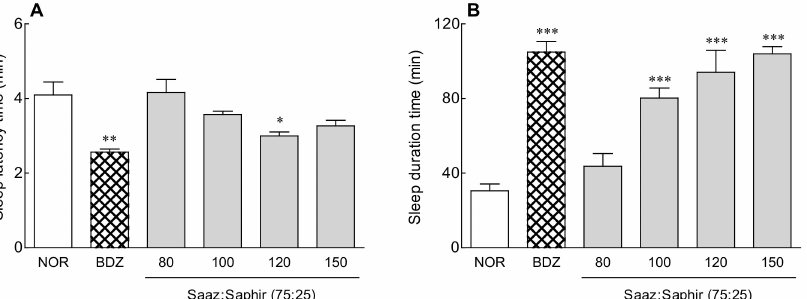
Figure 1. Effects of hops on the sleep latency time ( A ) and total sleep time ( B ) in mice that received a hypnotic dose of pentobarbital (42 mg/kg, i.p.). NOR: the 0.9% NaCl (physiological saline) group (normal control); BDZ: benzodiazepine treatment (positive control, 200 µ g/kg); and Saaz–Saphir mixtures (80, 100, 120, and 150 mg/kg). Values are presented as the mean ± standard errors of the mean (SEM) for each group, n = 7. * p < 0.05, ** p < 0.01, and *** p < 0.001 vs. NOR by Tukey’s multiple comparison